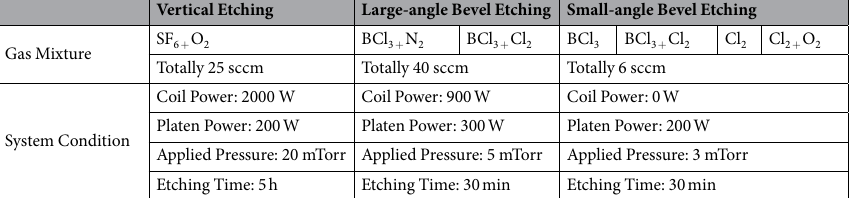
Figure 1(c) summarizes detailed measurement results of the Ni and Cr applied in this work. The etching rates observed when using Ni and Cr masks are 30 Å/min and 77 Å/min, respectively, when all other parameters are held constant to allow a SiC etching rate of 3050 Å/min. This discrepancy results in a selectivity of 100:1 for SiC:Ni and 40:1 for SiC:Cr. Because of this, the SF 6 -optimized etching conditions for SiC exhibit higher etching rates when Ni metal masks are used, approximately 3050 Å/min with a selectivity of 100:1. This was experimentally